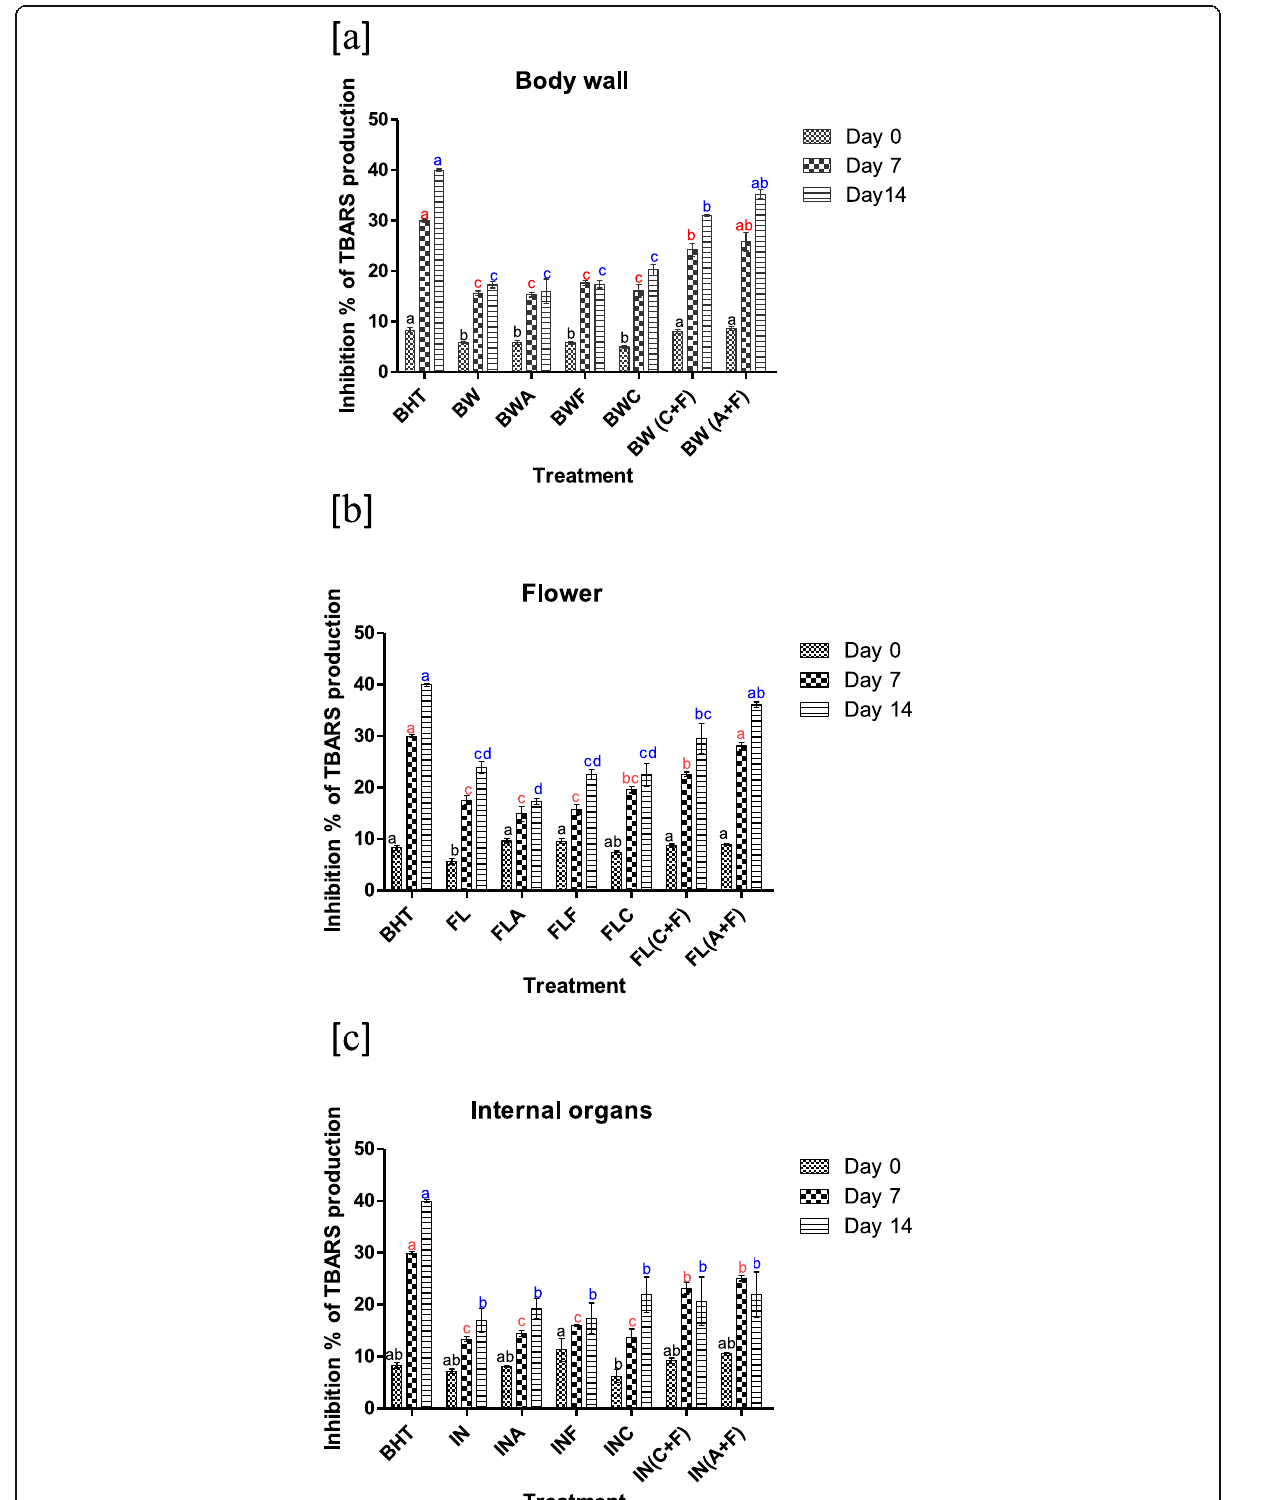
Fig. 8 Inhibition % of TBARS production of protein hydrolysates of sea cucumber C. frondosa protein hydrolysates a BW, Body wall; b FL, Flower; and c IN, Internal organs; A, Alcalase; F, Flavourzyme; C, Corolase; C + F, Mixture of Corolase and Flavourzyme; and A + F, Mixture of Alcalase and Flavourzyme. Different letters for the same concentration of all hydrolysates indicates significant difference at p <